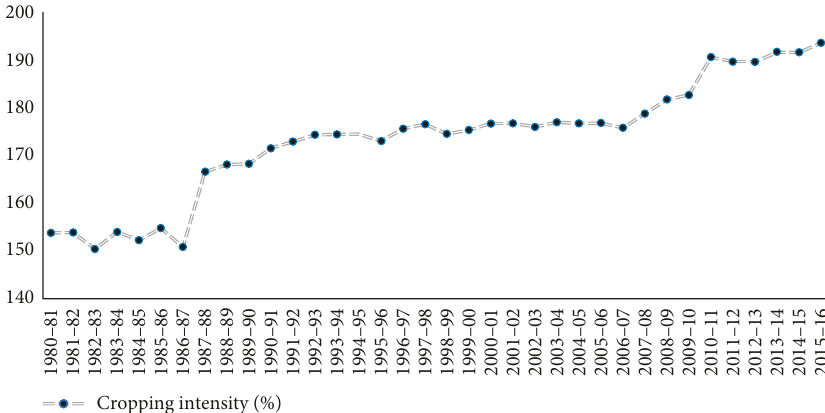
Figure 1: Trend of cropping intensity (%) in Bangladesh since 1980-81 to 2015-16 (BBS).